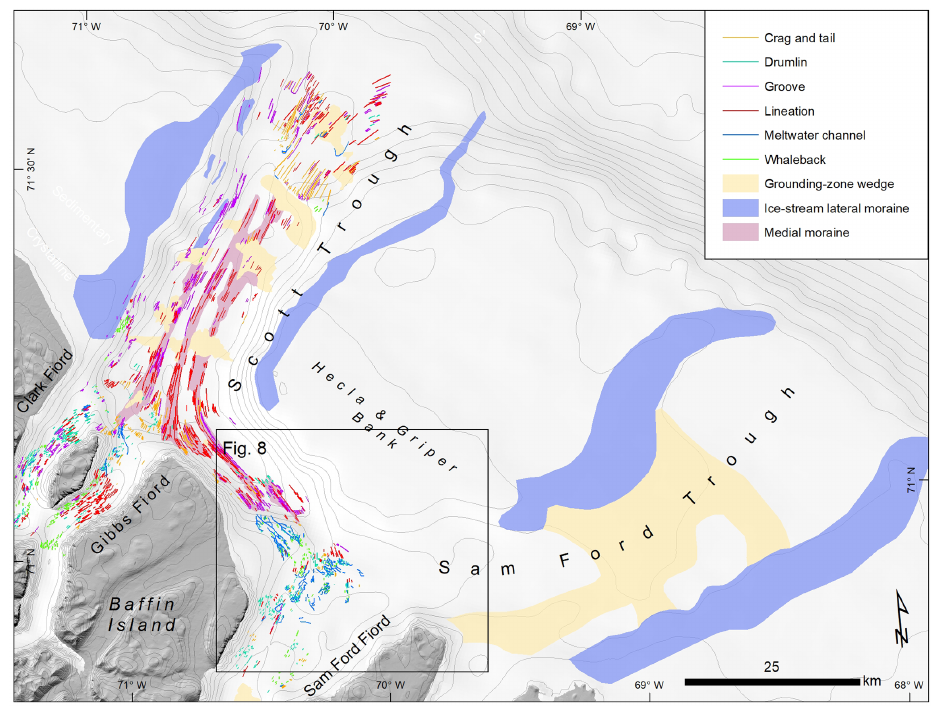
Figure 7. Distribution of landforms related to ice flow and to ice margin stabilization on the continental shelf and fiords of the study area in northeastern Baffin Island, eastern Arctic